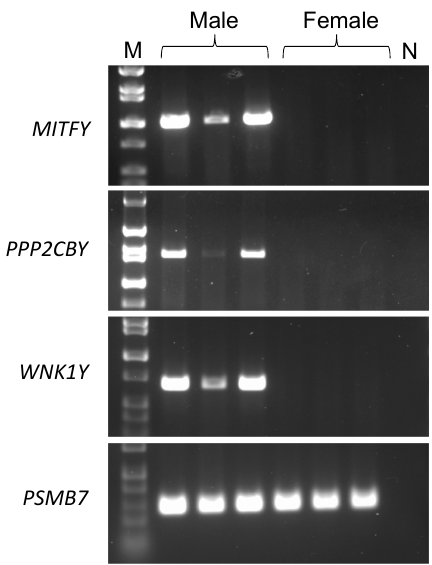
Figure 3. Primers were designed to detect Y-linked retrocopies of three genes, as well as the presence of a control autosomal gene ( PSMB7 ). Polymerase chain reaction using DNA from 3 male dogs and 3 female dogs showed male specific amplification for the 3 retrocopies (top three panels). Amplification for all dogs is shown for PSMB7 in the bottom